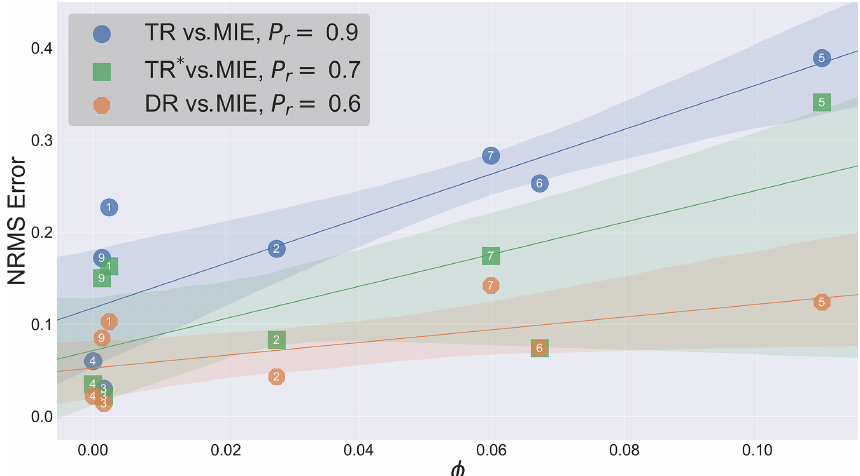
Figure 12. Correlations between the NRMS error and the forecast parameter φ , for DR, TR and TR ∗ estimates. The shaded areas indicate the 90% confidence region. Case ID is indicated for each data point. Pearson correlation coefficients ( P r ) for the three methods are also noted on the graph. Results indicate a strong correlation between NRMS error and the φ